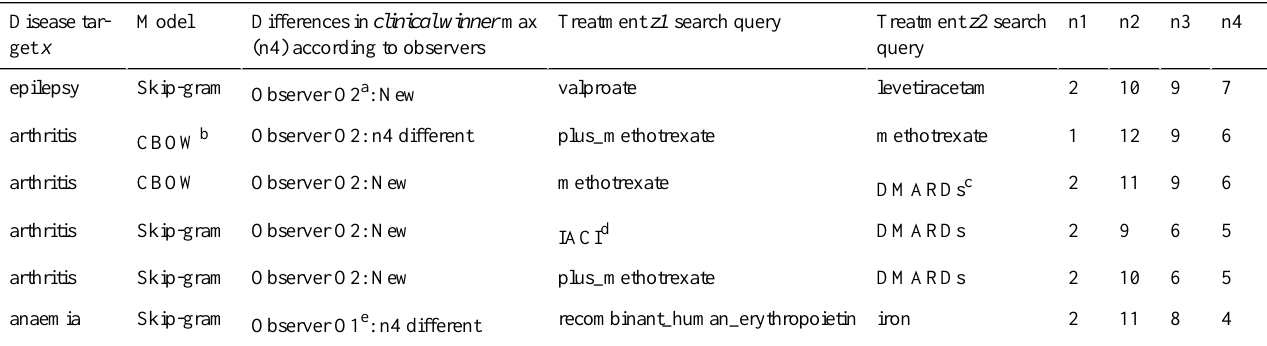
Table 5. Changes in clinical winners (highest value of n4) per model and disease target x considering observer O1 and O2.